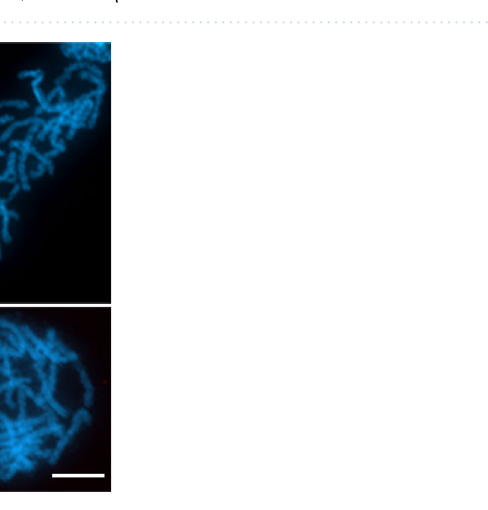
Figure 6. FISH mapping of PRW Bel-Pao on pachytene nuclei of Peribatodes rhomboidaria . ( A–C ) Female chromosomes with DAPI-positive W chromosome (arrow) showing strong hybridization signals, while no signals are visible on other chromosomes and on male pachytene chromosomes ( D ). ( A,D ) Merged image of DAPI staining and probe (red), ( B ) DAPI staining, ( C ) probe (red)—detail of the W chromosome. Bar = 10